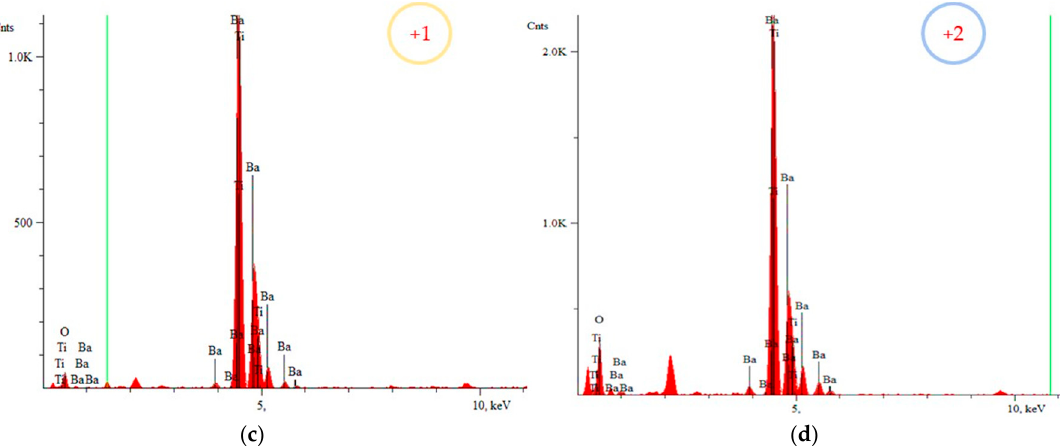
Figure 6. SEM-EDS points analysis: SEM image of the powder obtained ( a ), the summary of the content of the specific chemical elements ( b ) and the EDS spectrum in point 1. ( c ) and point 2. ( d ) marked on the SEM image.